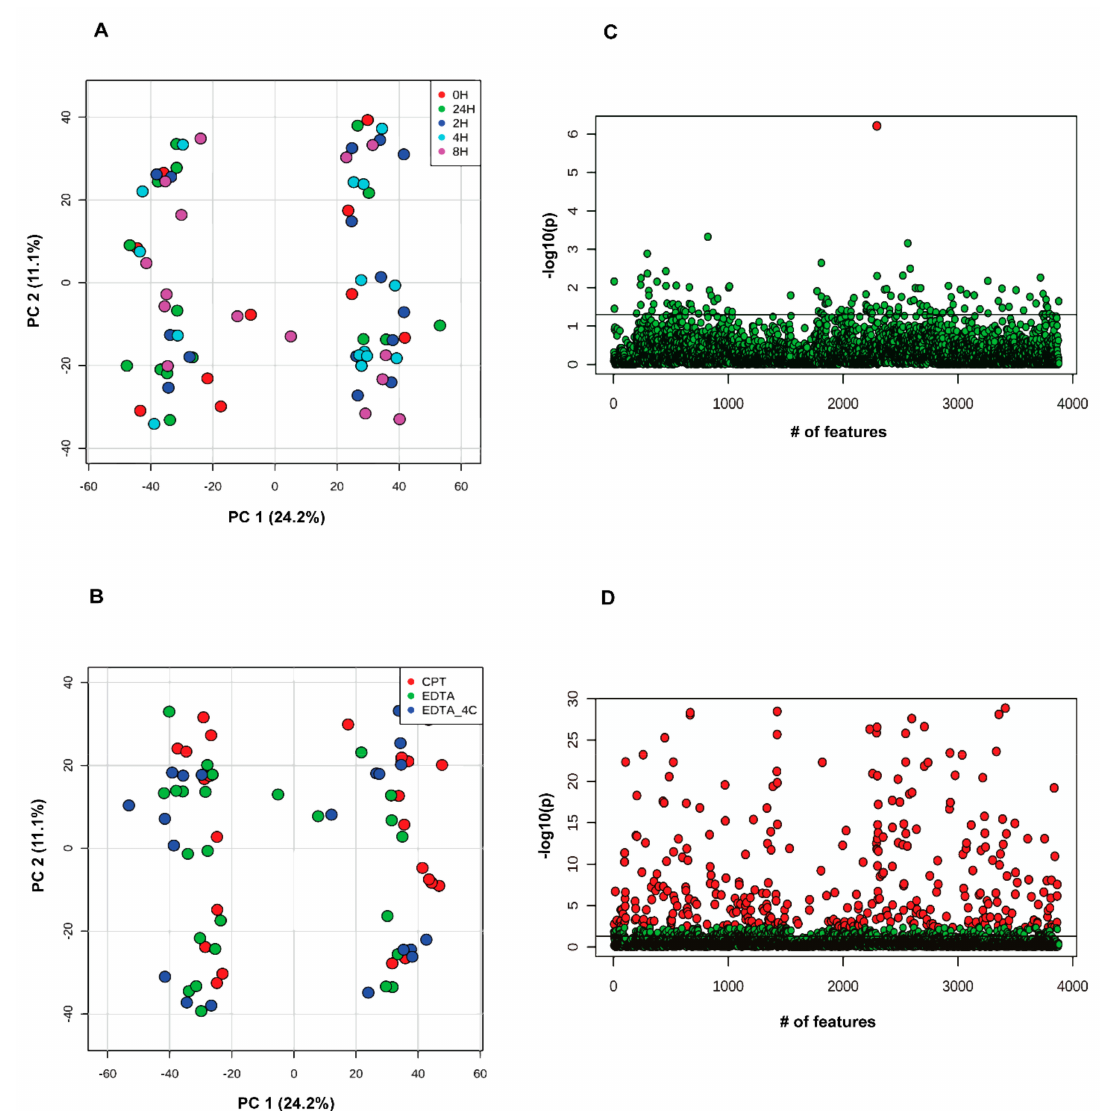
Figure 2. Principal component analysis in donor-unmatched samples from lipidomics data acquired in positive ionization mode. Samples are grouped by ( A ) storage time and ( B ) anticoagulants used. Analysis of variance with Fisher’s Least Significant Di ff erence (LSD) test at adjusted p-value at 0.05 grouped by ( C ) storage time (red dot show p -value < 0.05) and ( D ) anticoagulants (red dots show p -value < 0.05). Note: The Y -axis scale of scatter plot is automatically adjusted by Metaboanalyst based on the range of − log10(p). The line on the scatter plot demarcates the − log10(0.05) value on Y